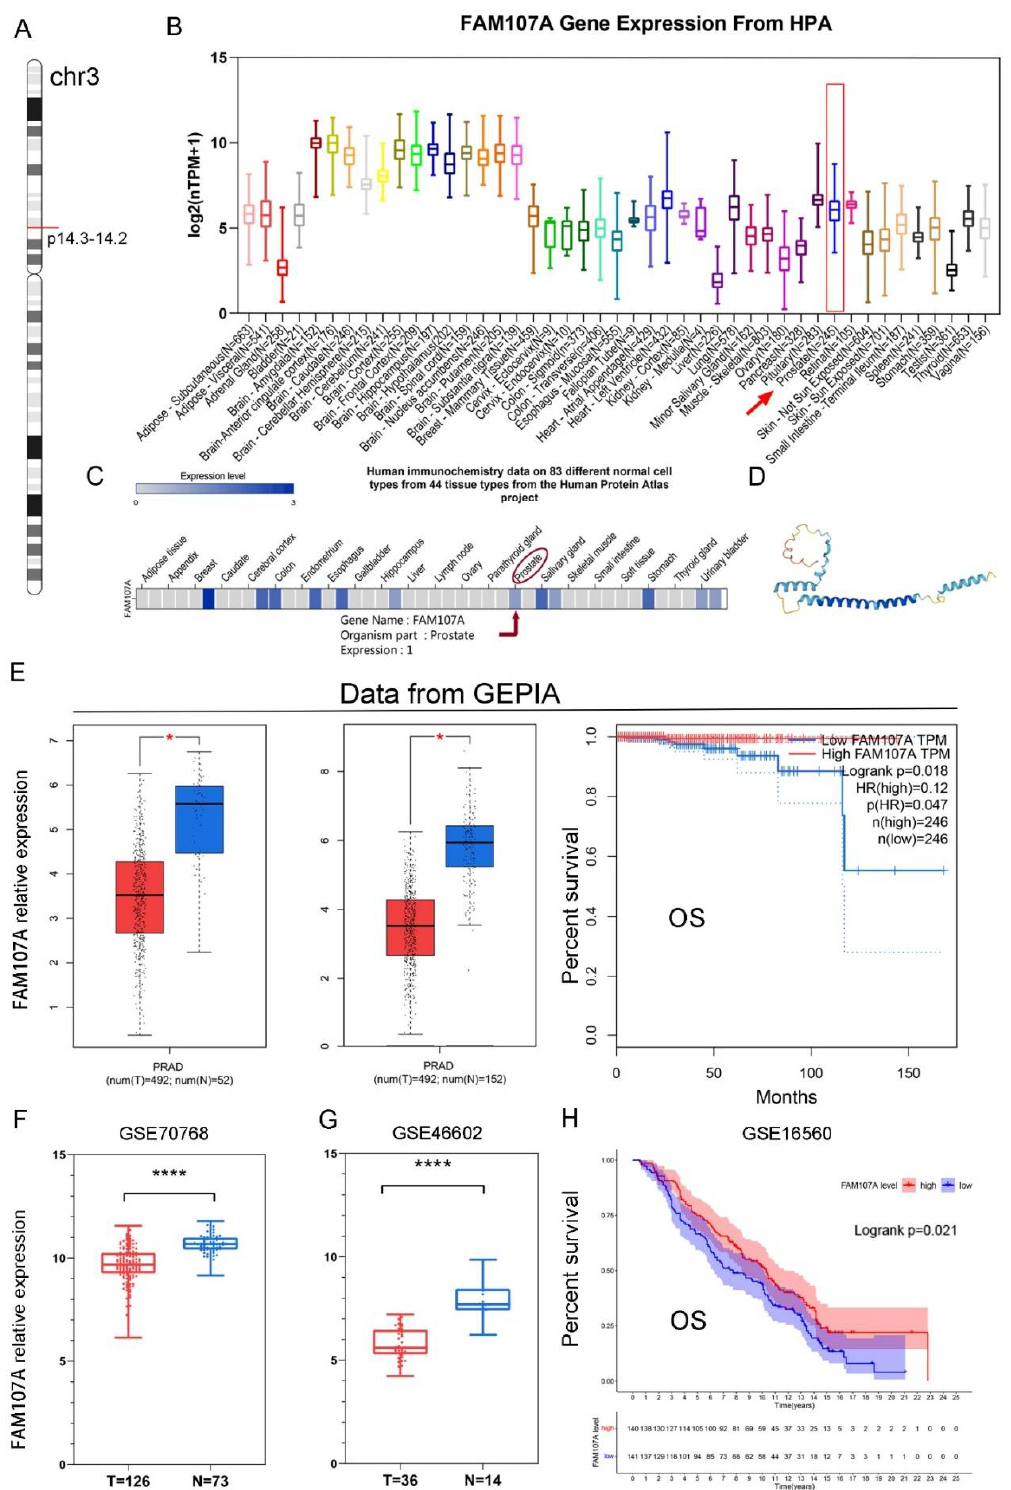
Figure 1. Chromosomal localization of FAM107A in PCa, expression characteristics of FAM107A gene, and its correlation with clinical prognosis. ( A ) FAM107A is located in the short-arm region of chromosome 3. ( B ) Tissue expression of human FAM107A gene. Distribution of RNA expression of FAM107A gene in normal tissue types. It was created using the transcriptomic dataset of the Human Protein Atlas database. ( C ) FAM107A protein expression in prostate tissue according